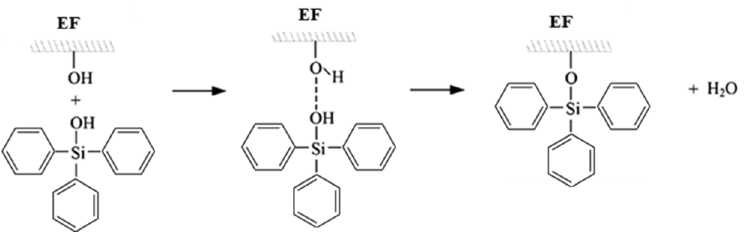
Figure 2. Silane treatment of eucalyptus fibers.